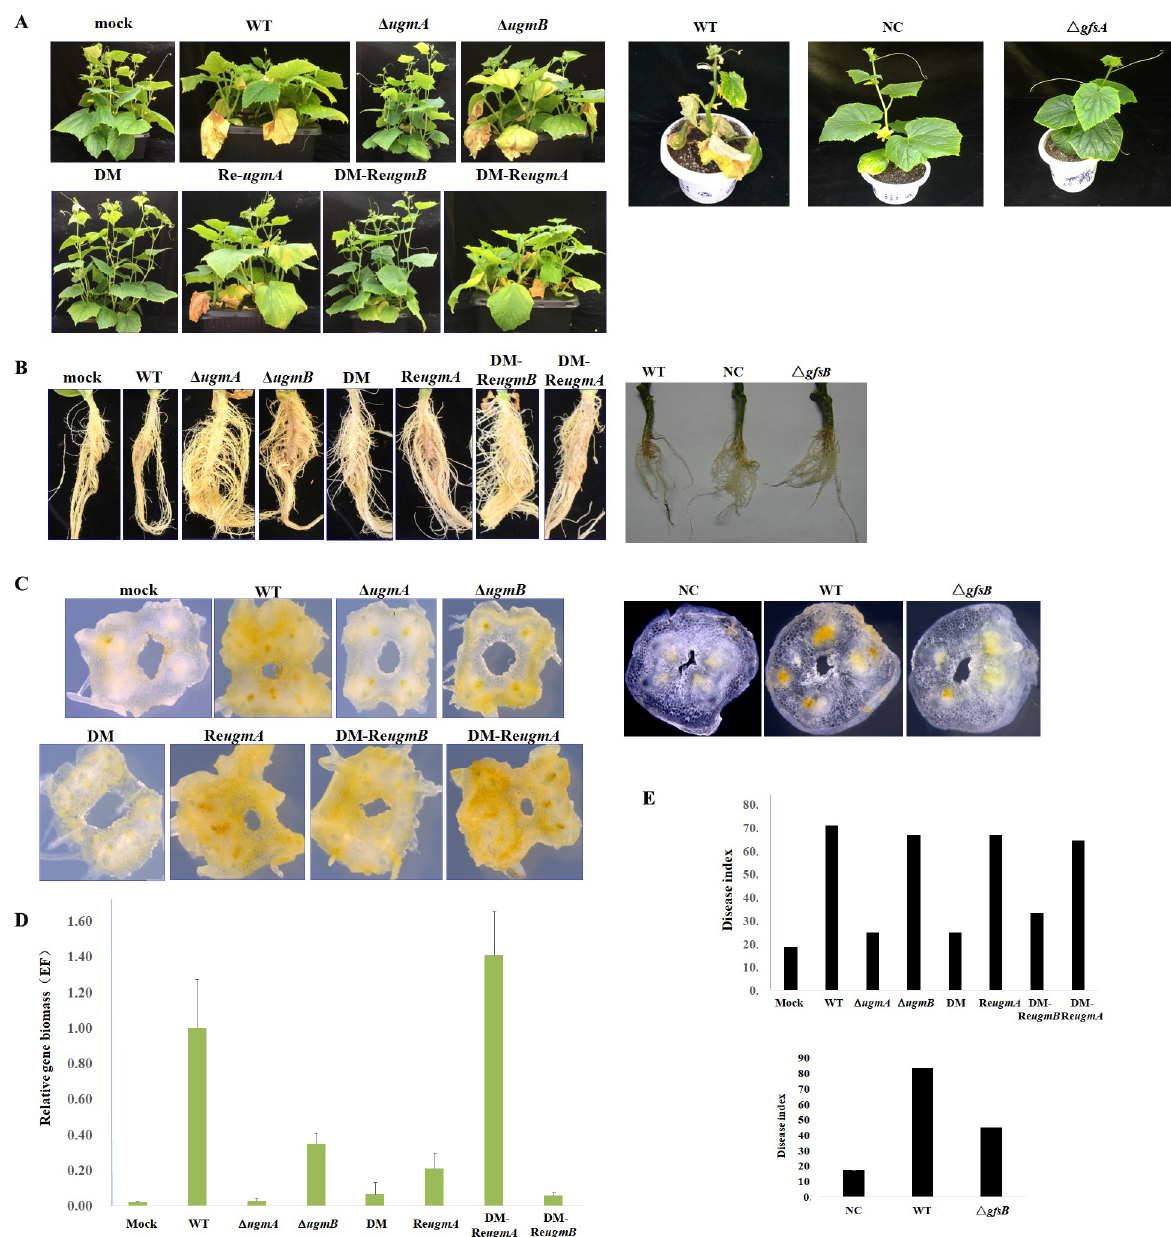
Fig 7. Virulence of the mutant strains. In A and B, the germinated cucumber seeds in plastic pots were grown in the greenhouse at approximately 28˚C for a 16 h photoperiod until the two-true leaves stage. The infected seedlings were analyzed after 45 days. Twelve plants were used for each treatment. In C, the root cross sections of infected plants were observed with M205A stereoscopic microscope (Leica Microsystems) ( × 20). In D, to quantify the relative mycelial biomass of the fungal strains in cucumber roots, DNAs were extracted from the cucumber roots cultured for 30 days after infection and subjected to quantitative PCR (qPCR) using primers EF1a-1/-2 for the transcription elongation factor gene of F . oxysporum as described in Materials and methods. In E, disease severity index (DSI) was calculated as previously described from 2 weeks of inoculation up to 45 days. The plant infection experiments were repeated for three